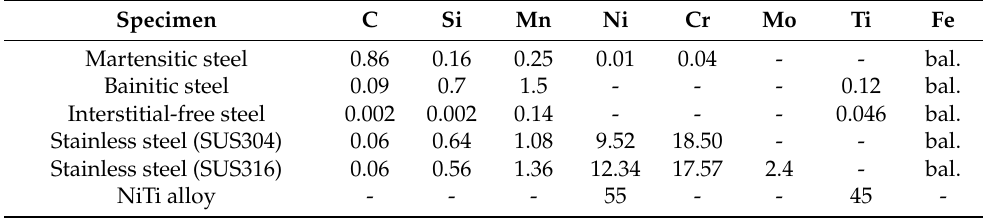
Table 1. Chemical composition of tested alloys